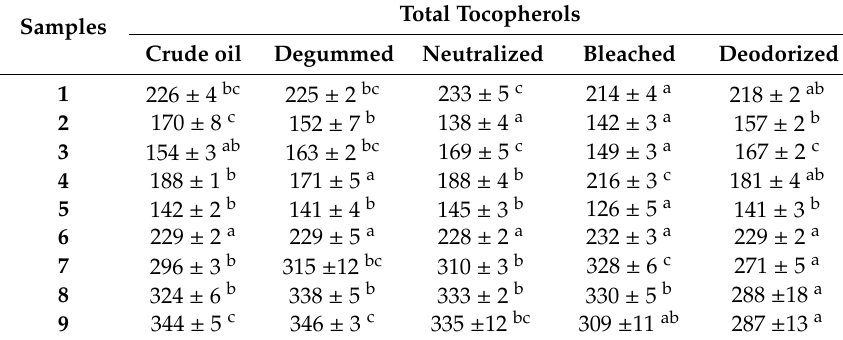
Table 3. E ff ect of the refining steps on the total tocopherol content (mg / kg oil). Table 3. Effect of the refining steps on the total tocopherol content (mg/kg oil).